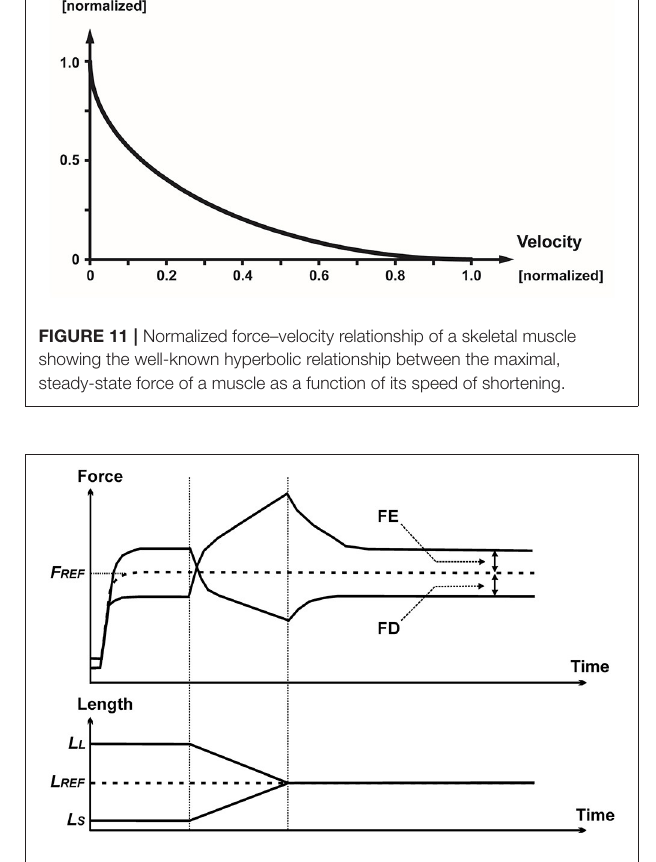
FIGURE 12 | Force–time (top panel) and length–time (bottom panel) history of the contractile properties that produce residual force enhancement (FE) and residual force depression (FD). The dashed line labeled F REF represents the force obtained in an isometric reference contraction. Force enhancement represents the increase in steady-state isometric force (relative to F REF ) of a muscle following active stretching, and force depression is the decrease in steady-state isometric force (relative to F REF ) following active